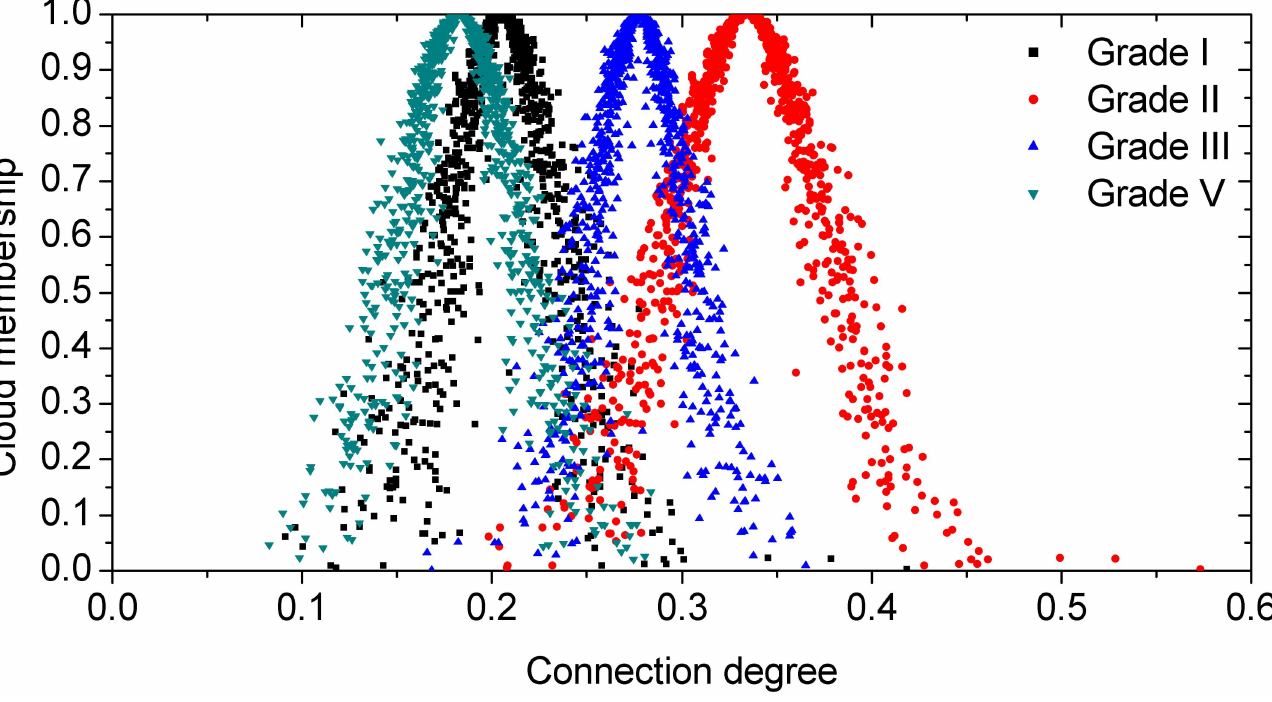
Fig 3. Normal clouds of CCD for Huangtukan